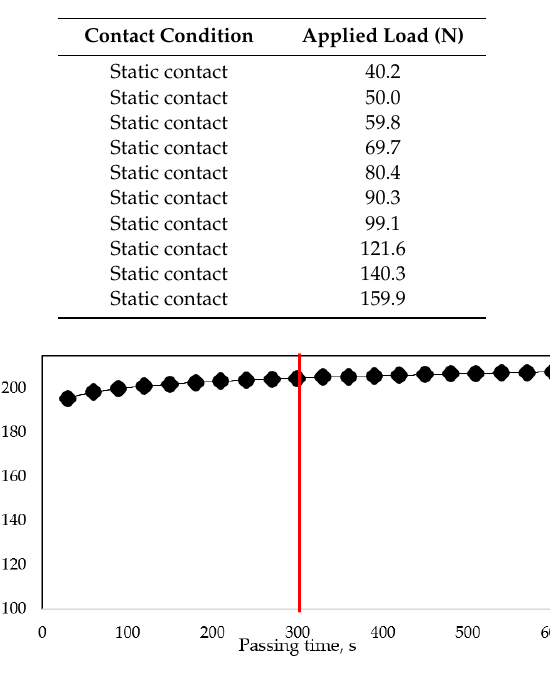
Table 3. Experimental conditions for static contact.